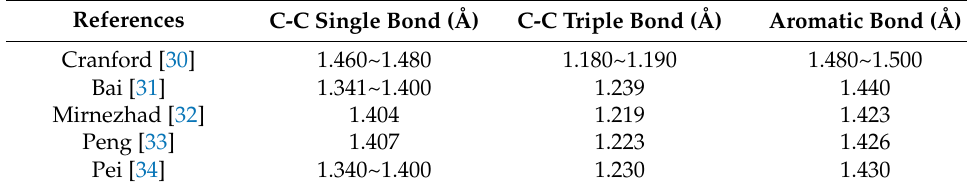
Figure 2. Supercell structure of intrinsic γ -GDY models. Table 1. Related research of the C-C bond length of intrinsic γ -GDY.